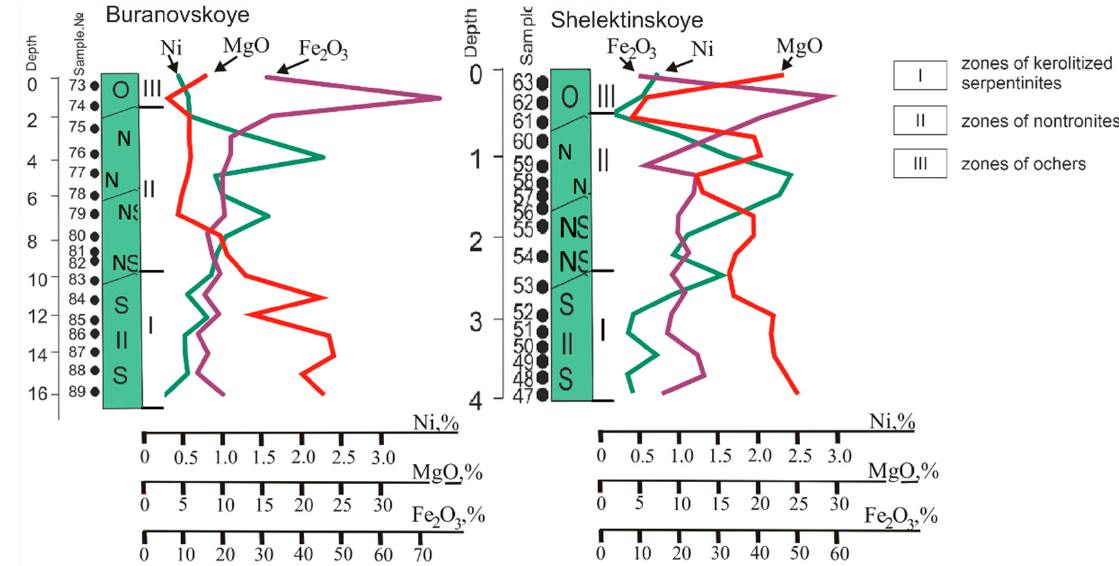
Figure 10. Diagram of Ni, MgO, and Fe 2 O 3 distribution in the section of the weathering crust of ultramafic rocks of Buranovskoye and Shelektinskoye deposits, according to thermal and chemical analyses.